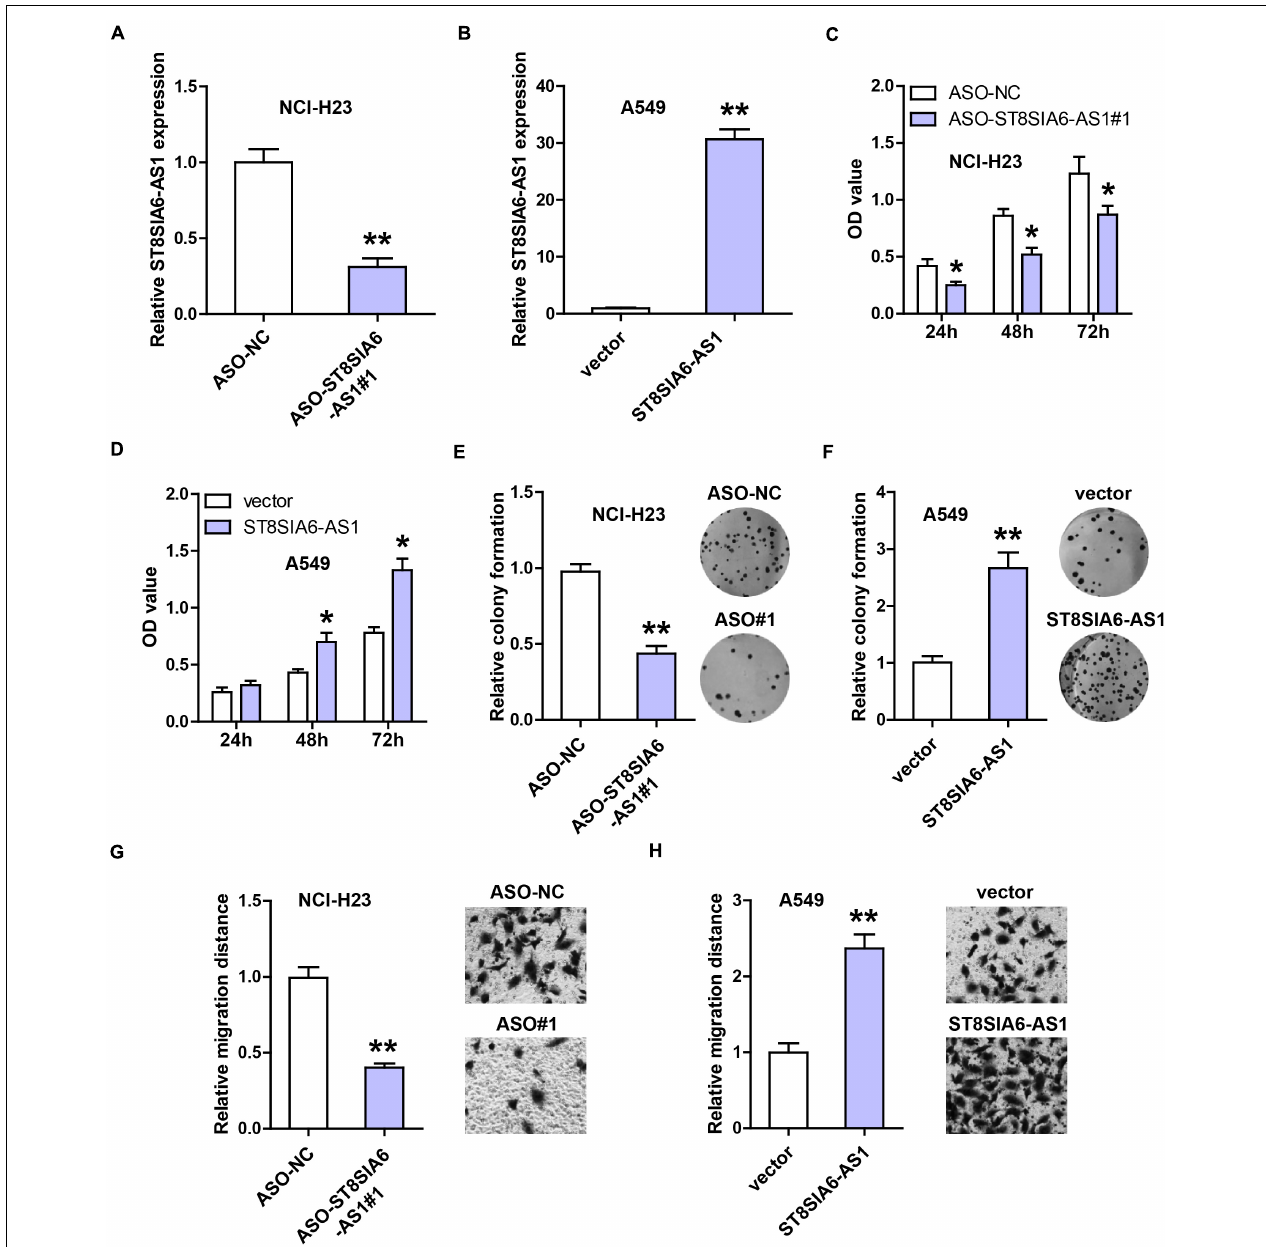
FIGURE 3 | ST8SIA6-AS1 promotes LUAD cell malignant phenotype. (A,B) qRT-PCR analysis verifying the silencing and overexpression efficiencies in NCI-H23 and A549 cells, respectively. (C–H) CCK-8, colony formation, and transwell assays testing cell viability, colony ability, and migration after alteration of ST8SIA6-AS1 level, respectively. * P < 0.05, ** P <